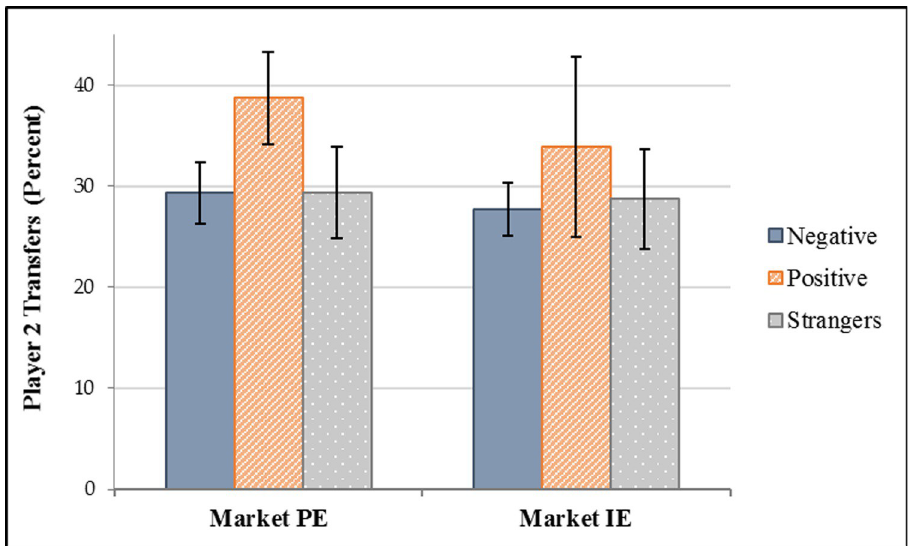
Fig 2. Player 1 transfers in Markets PE and IE by relationship type. The error bars represent standard errors. Graph presents Player 2 transfers by different relationship types across treatments. The first set of bars represents Player 2 transfers in Market PE and the second set of bars represents Player 2 transfers in Market IE. Within each set of bars, from left to right, the bars represent negative relationships, positive relationships, and subject pairs with no trading relationships.